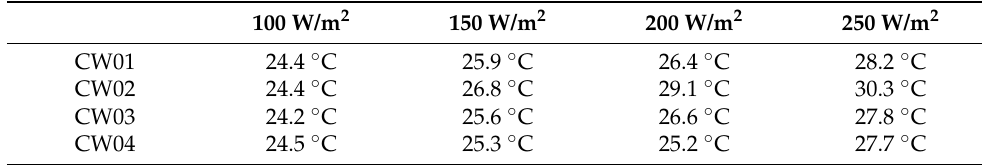
Figure 12. Comparison between simulation and infrared camera for CW03 — 250 W/m 2 . The same boundary conditions used in the tests were applied to numerical simulations of each global system containing the four different types of concrete block. The average temperature of the external face of the wall was determined. The results are presented in Table 8. Table 8. Results of the numerical